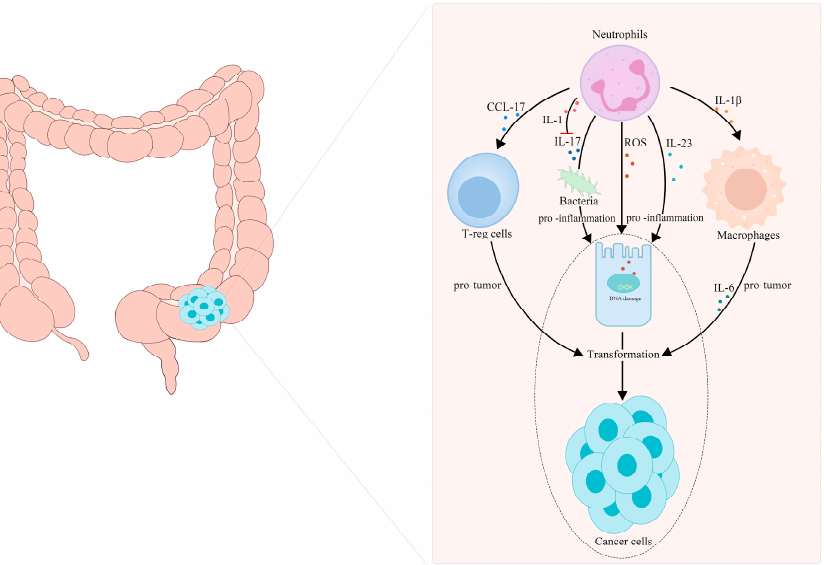
Figure 2. TANs participate in the transformation of inflammation into CRC. (1) TANs recruit T-reg cells and macrophages to participate in tumor progression by releasing CCL17 and IL-I β , respectively. (2) TANs release ROS, reactive nitrogen species and some enzymes to cause gene mutations and DNA damage, secrete IL-17 to maintain the diversity of the intestinal bacterial population and secrete interleukin, such as IL-23, to promote intestinal inflammation, which jointly promote the transformation of intestinal inflammation to tumor malignancy.